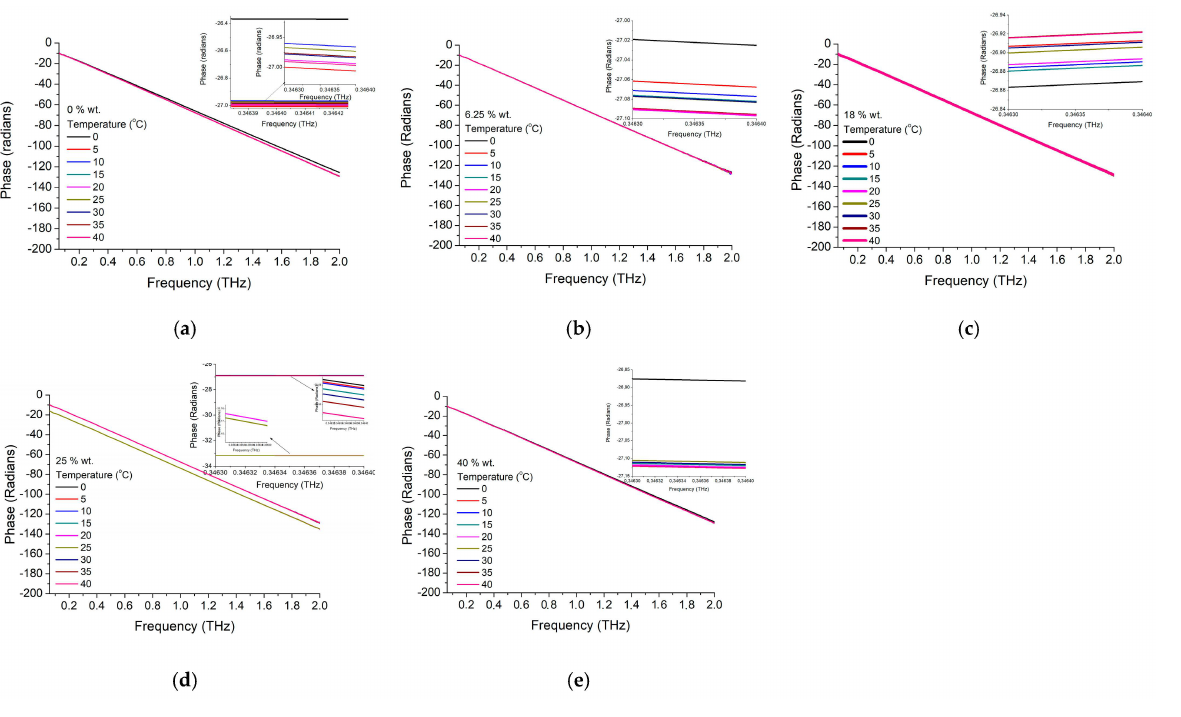
Figure 7. BTO-gelatin phase variation with frequency at ( a ) 0 wt.%, ( b ) 6.25 wt.%, ( c ) 18 wt.%, ( d ) 25 wt.%, and ( e ) 40 wt.%.